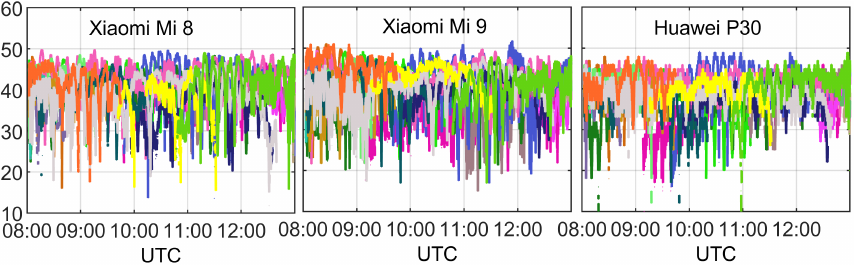
Figure 2. C / N 0 time series of GNSS signals collected by Xiaomi Mi 8, Xiaomi Mi 9, and Huawei P30 in left, middle, and right panels, respectively. The values corresponding to different satellites are distinguished by different